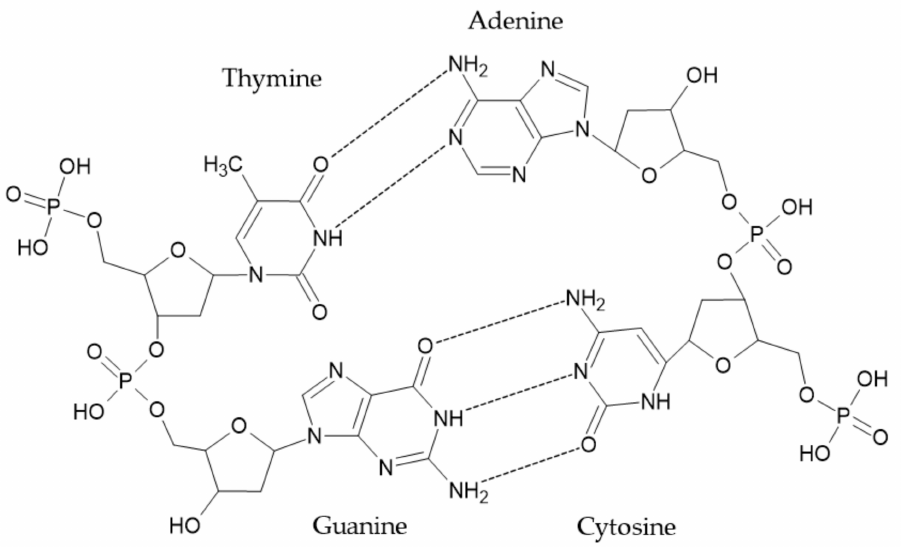
Figure 11. The molecular structure of DNA